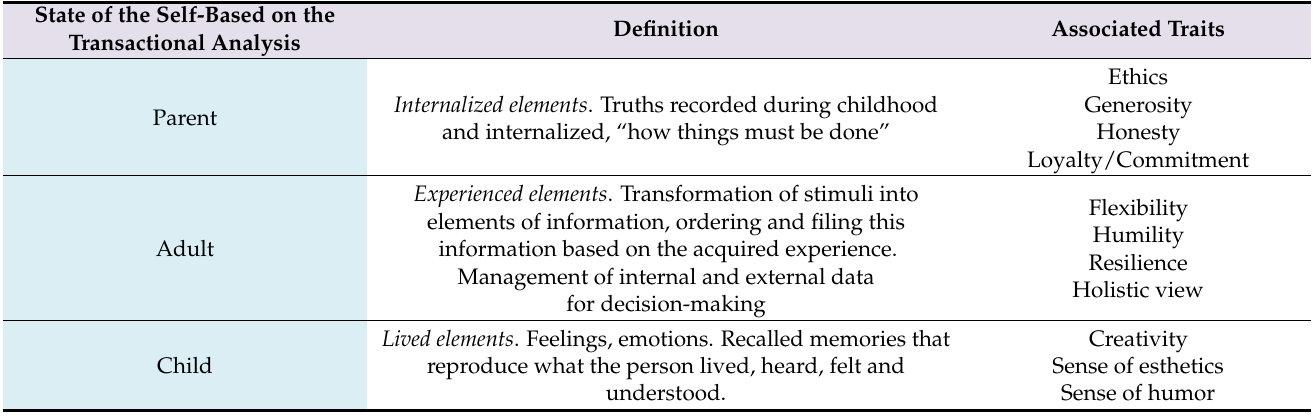
Table 3. States of the self and personality